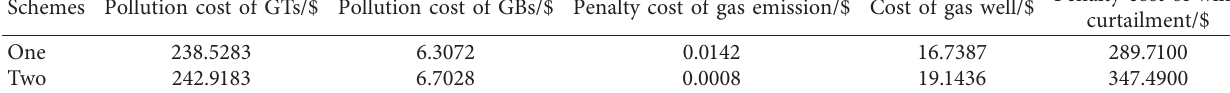
Table 5: Specific operating cost values.